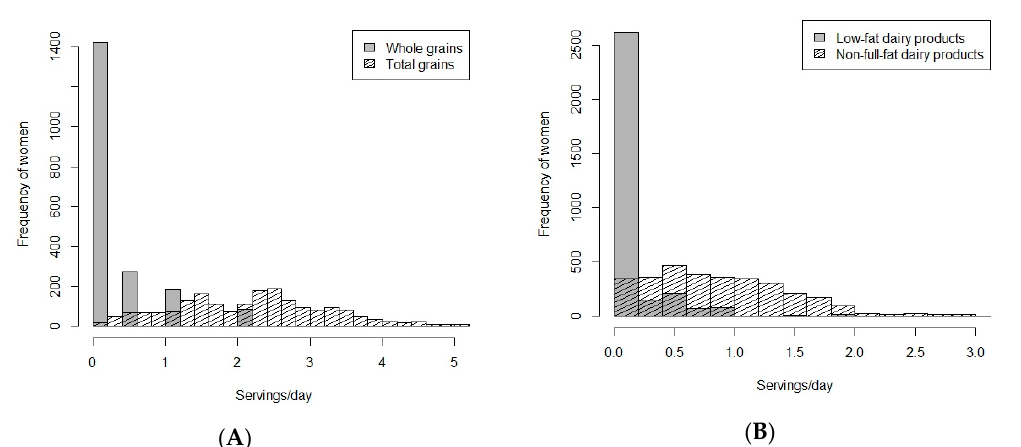
Figure 1. Distributions of servings / day (at pre-pregnancy period) between ( A ) whole grains and total grains in EDEN; and ( B ) low-fat and non-full-fat dairy products in SWS.